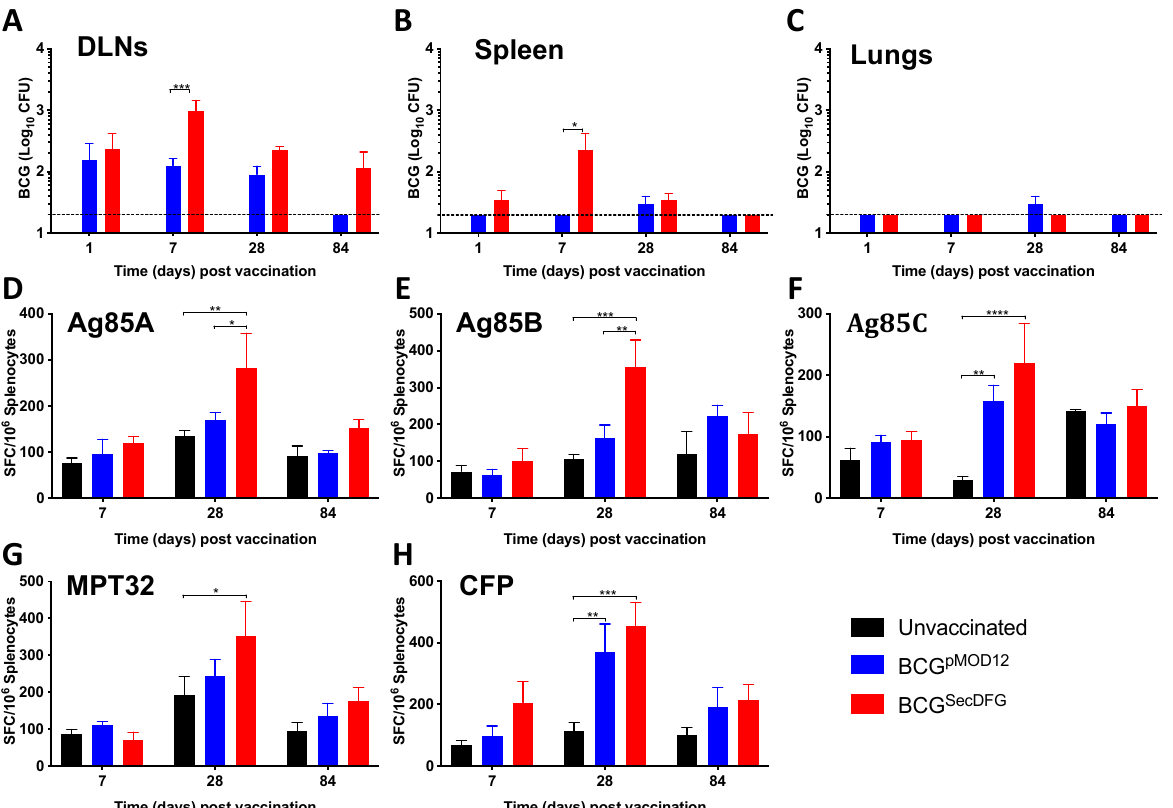
Figure 2. Persistence and immunogenicity of BCG SecDFG in mice. C57BL/6 mice were left unvaccinated (black bars), or vaccinated s.c. with 5 × 10 5 CFU BCG pMOD12 (blue bars) or BCG SecDFG (red bars), and the bacterial load was determined in the DLNs ( A ), spleens ( B ), and lungs ( C ) at days 1, 7, 28, and 84. Splenocytes from days 7, 28, and 84 were stimulated ex vivo with 10 μ g/mL of Ag85A ( D ), Ag85B ( E ), Ag85C ( F ), MPT32 ( G ), or CFP ( H ) for approximately 20 h at 37 °C. The number of antigen-specific IFN- γ -secreting cells was enumerated by ELISPOT. The data are the means ± SEM and representative of two independent experiments. Detection limit of the assay shown by the dotted line (20 CFU/organ). Statistical significance was determined by ANOVA with Tukey’s multiple-comparisons test (* p < 0.05; ** p < 0.01; *** p < 0.001; **** p < 0.0001). The increased persistence of the BCG SecDFG in the lymphoid organs, together with the increased IFN- γ responses in the vaccinated mice, suggested the vaccine may induce the increased priming of T cells. To test this, p25 transgenic CD4 + T cells specific for the dominant P25 epitope of Ag85B (CD45.1 + ) were transferred to recipient C57BL/6 mice (CD45.2 + ), and the next day, the mice were vaccinated s.c. with the BCG strains (Figure 3A). The mice that received the BCG SecDFG had significantly higher numbers of p25 CD4 + T cells in the LNs and spleens compared to the mice that received the BCG pMOD12 (Figure 3B). A similar pattern of cytokine-producing P25 CD4 + T cells was observed from the LN cells, with both BCG strains generating a high proportion of triple-positive IFN- γ + IL-2 + TNF + CD45.1 + T cells at day 6 post-vaccination (Figure